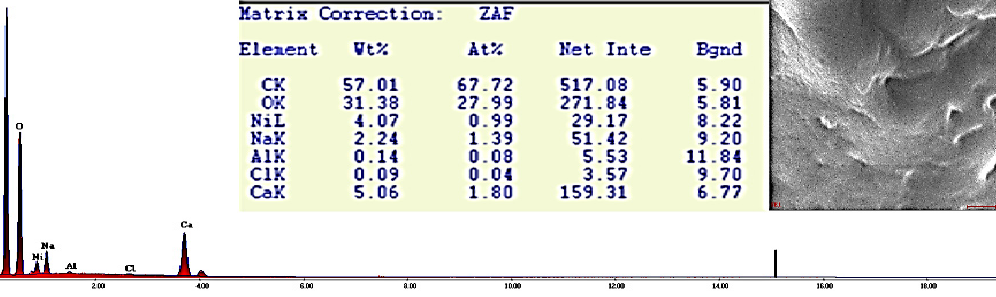
Figure 7. EDX spectrum of CA–SCGs bead after adsorption at 100 ppm Ni 2+ (X-ray lines K or L for each element).